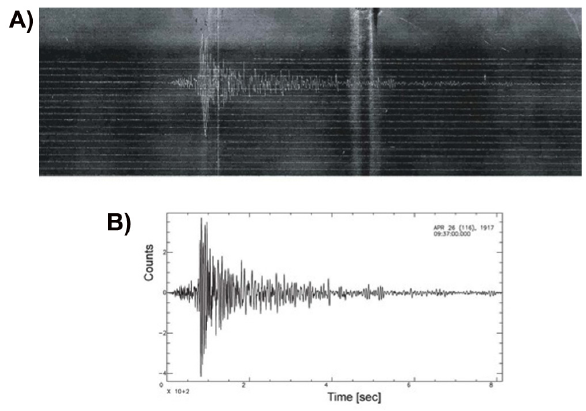
Figure 7. Example of a raster (A) image: the seismogram was recorded on smoked paper by the Wiechert seismograph at Zagabria station, NW component for the April 26, 1917, earthquake. Vec- torized image (B) derived from the raster image using teseo2, a neu- ral network based program, which converts raster images into sampled series.